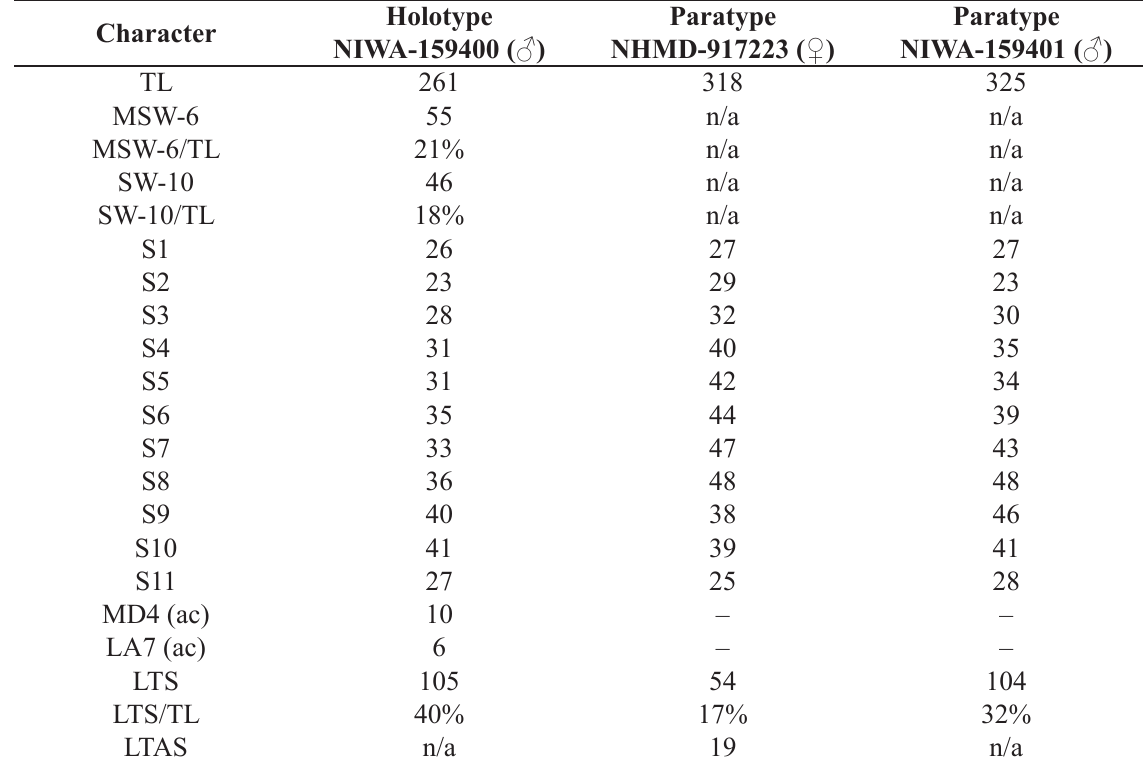
European Journal of Taxonomy 844: 1–108 Table 2. Measurements from light microscopy of Echinoderes blazeji sp. nov . (in µm) from the Hikurangi Margin.